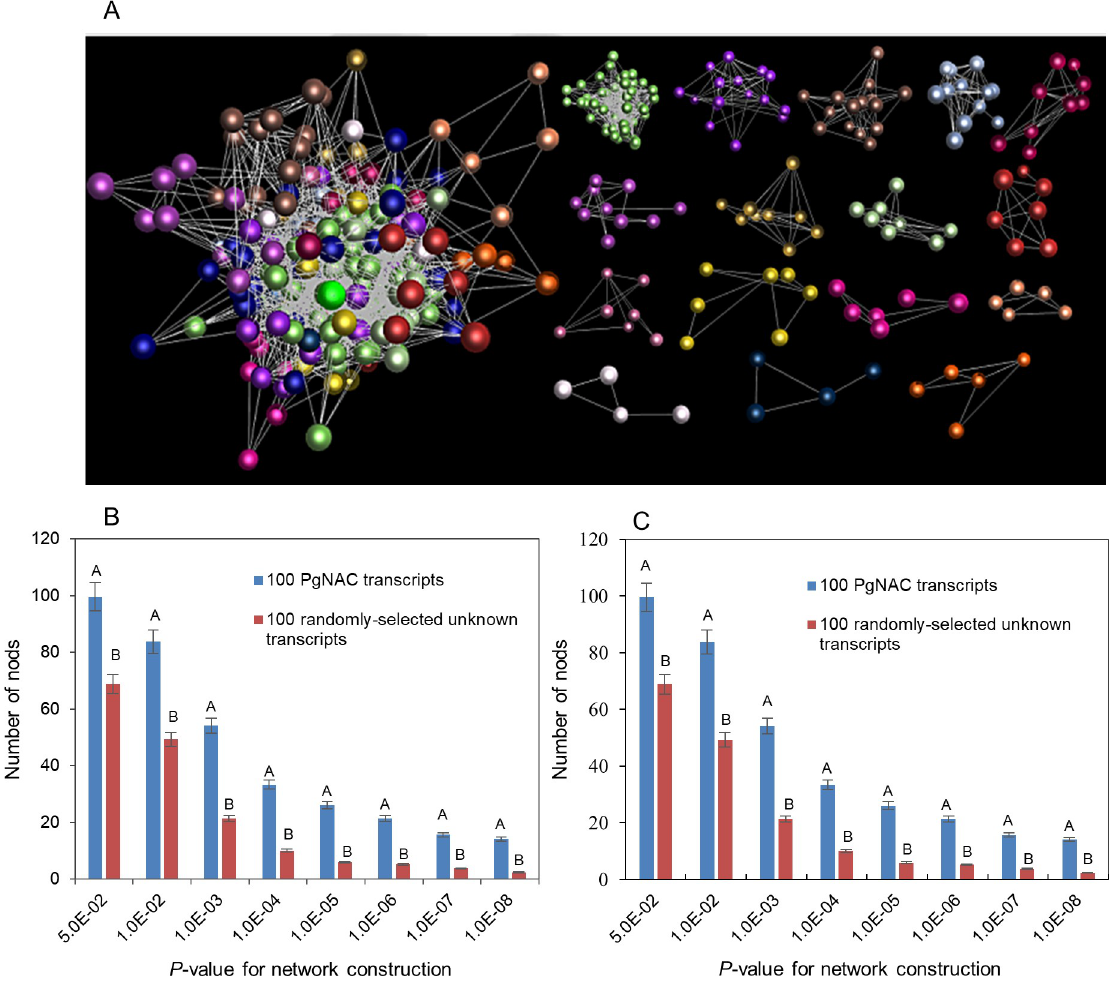
Fig 7. Co-expression network of the PgNAC transcripts in the four-year-old plant roots of 42 genotypes. These 42 ginseng genotypes were collected from the origin and diversity center of ginseng, Jilin, China. (A) The co-expression network and its clusters constructed from 218 of the 251 PgNAC transcripts at P � 5.0E-02. The network consisted of 218 PgNAC transcript nodes and 2,245 co-expression edges. (B) Statistics of the tendency of the PgNAC transcripts forming a co-expression network: number of nodes. (C) Statistics of the tendency of the PgNAC transcripts forming a co-expression network: number of edges. The 100 PgNAC transcripts were randomly selected from the 251 PgNAC transcripts identified in this study by bootstrap sampling, with 10 replications, while the 100 randomly-selected unknown transcripts were randomly selected from Database A [17]. Different capital letters indicate that the difference is significant at a two-tailed significance of P �